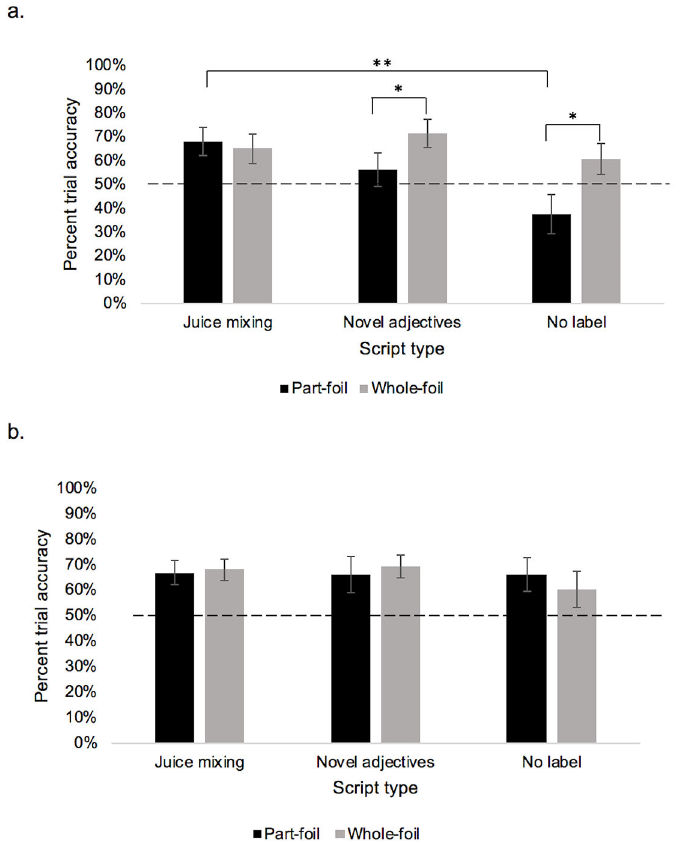
Figure 2. Percent accuracy by exemplar, script type, and foil type. One-exemplar conditions (a). Two-exemplars conditions (b). Error bars indicate one standard error of the mean. Dashed lines indicate chance performance (50%). * p < .05. ** p <